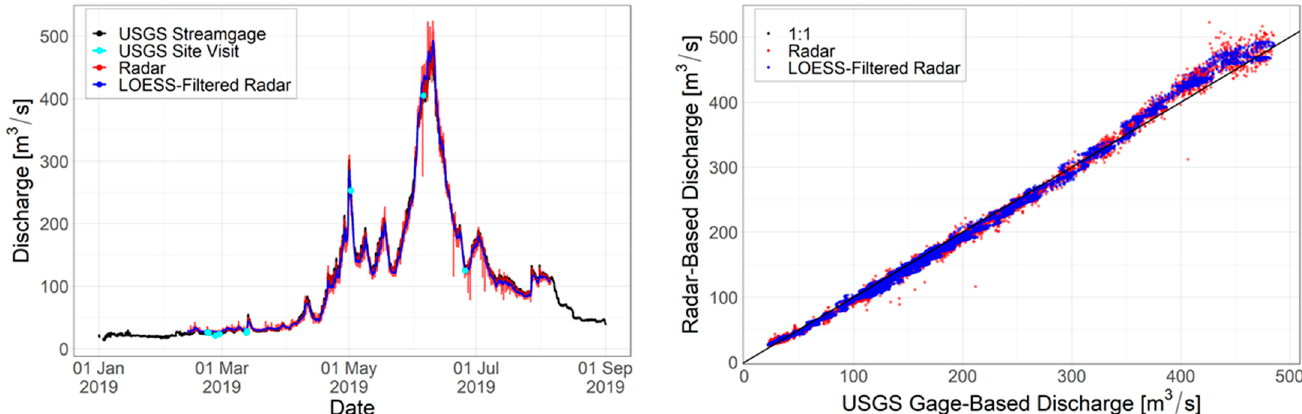
Figure A1. Comparisons of unfiltered (raw) radar-based discharge estimates (red), LOESS-filtered radar-based discharge estimates (royal blue), continuous USGS-streamgage-based discharge estimates (black), and USGS site visit stage discharge measurements (cyan), for the fully radar-based, trained- φ dataset, including a time series ( left ) and a scatterplot ( right ).